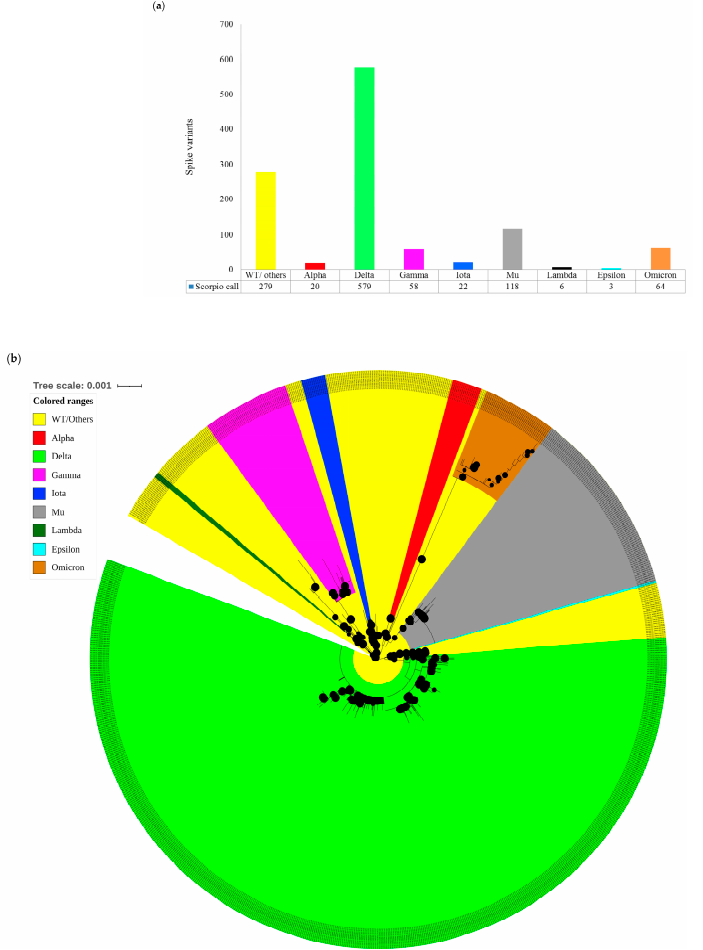
Figure 1. Detection and characterization of SARS-CoV-2 variants circulating in the Dominican Republic from March 2020 to February 2022. ( a ) The SARS-CoV-2 variant designations were obtained using the Pango lineage website (https://cov-lineages.org/ (accessed on 25 February 2022)) (n = 1149). Lineages not confirmed by Scorpio were grouped into WT or others. ( b ) The phylogenetic evaluation was inferred using the maximum likelihood method implemented in the IQ TREE web server. The bootstrap consensus tree was inferred from 1000 replicates. The colors indicate the SARS-CoV-2 spike variant, and the bullets ( • ) indicate branches with a bootstrap value of >0.70. The visualization was created using the online software tool iTOL v.5 ( b